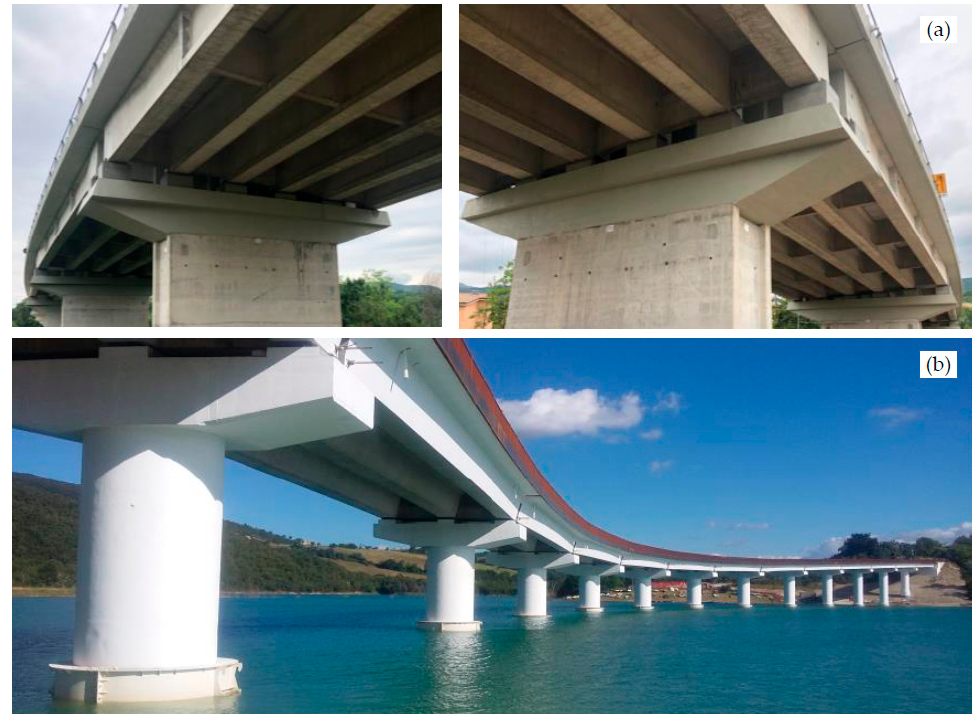
Figure 5. Pictures relevant to the bridges after the retrofitting works: ( a ) the B1 and ( b ) the B2 bridge.